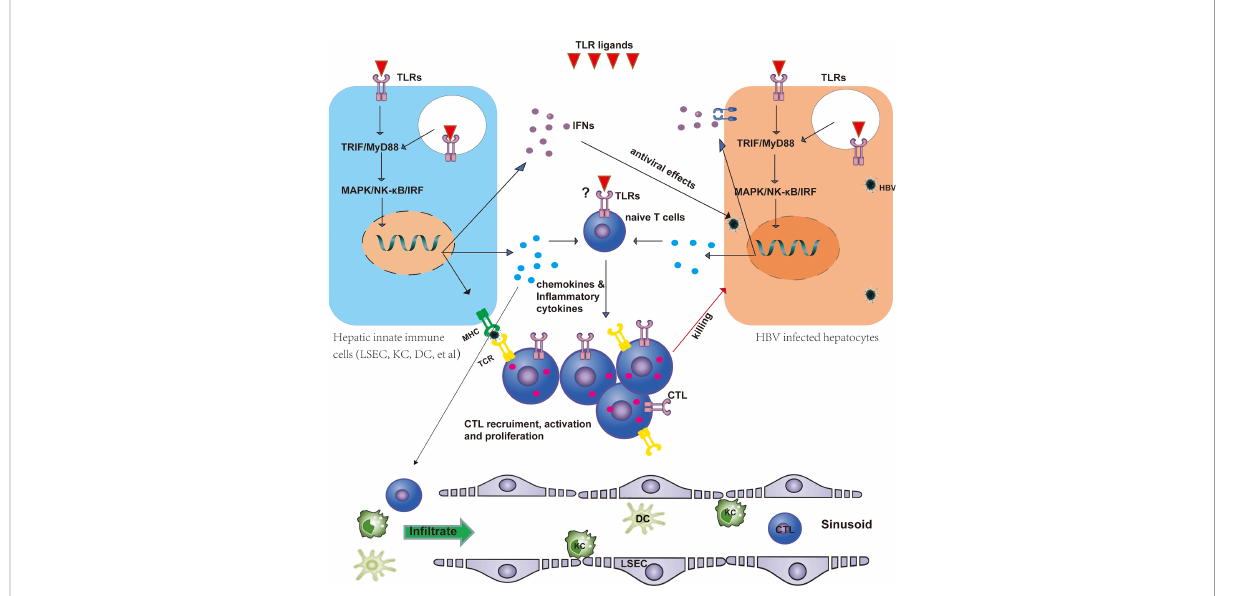
FIGURE 1 TLRs regulate HBV-speci fi c T-cell responses. TLRs are expressed in T cells, hepatocytes, and hepatic non-parenchymal cells, including LSECs, KCs, and DCs. TLRs may directly shape the T-cell response as costimulatory molecules. Stimulation of TLRs by their ligands leads to the activation of the downstream MyD88/TRIF-dependent signaling pathway in hepatic non-parenchymal cells and promotes the maturation of these cells, thus promoting antigen presentation to T cells and the production of IFNs, proin fl ammatory cytokines, and chemokines. IFNs exert antiviral effects against HBV in infected hepatocytes. Chemokines and in fl ammatory cytokines recruit DCs, macrophages, and speci fi c T cells into the liver and promote HBV-speci fi c T-cell activation and proliferation. Activated CLTs then kill infected hepatocytes. CTL, cytotoxic T cell; DC, dendritic cell; HBV, hepatitis B virus; IFN, interferon; LSEC, liver sinusoidal endothelial cell; KC, Kupffer cell; TLR, Toll-like